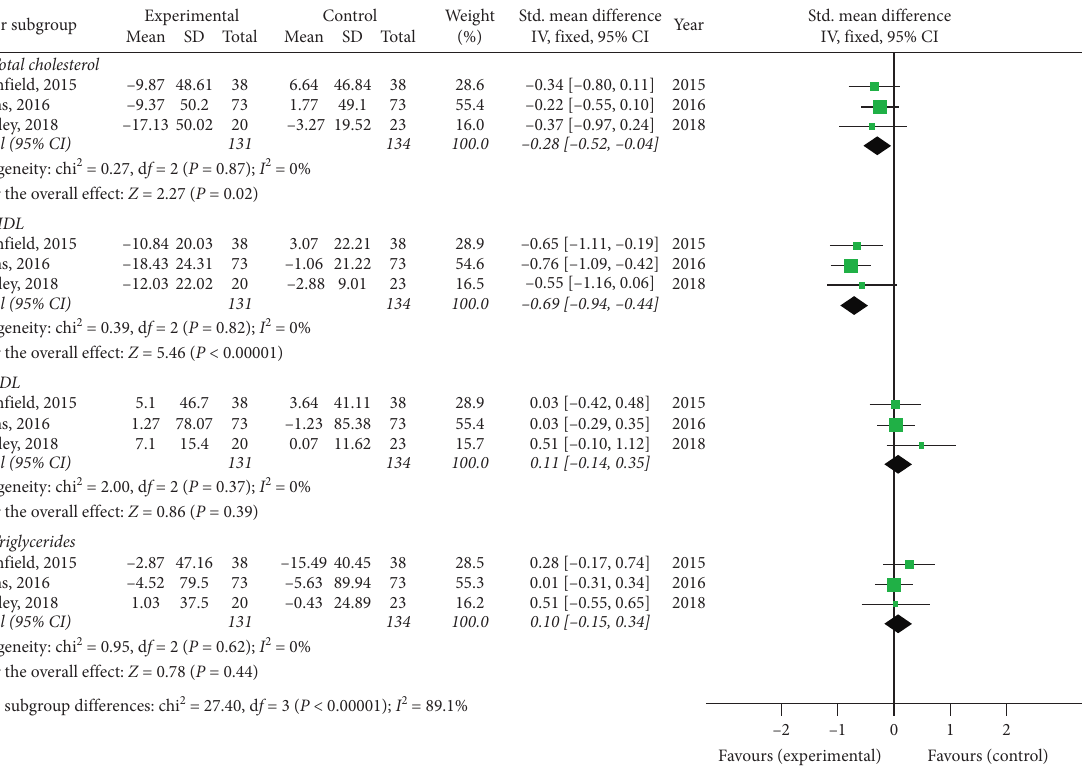
Figure 6: Effects on the lipids level in patients with PBC treated with OCA versus